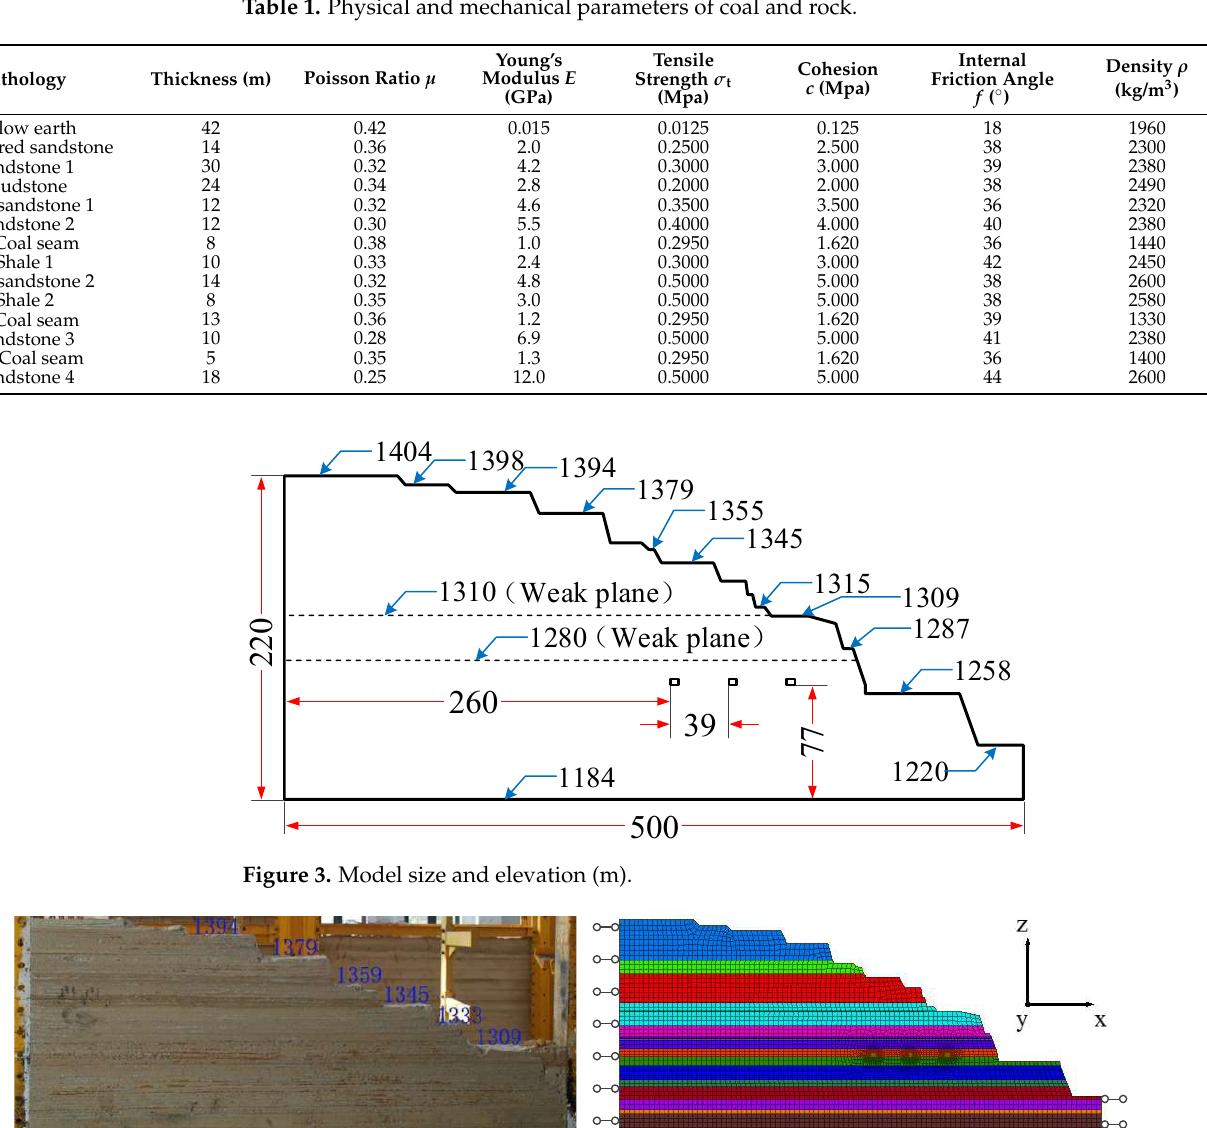
Table 1. Physical and mechanical parameters of coal and rock.